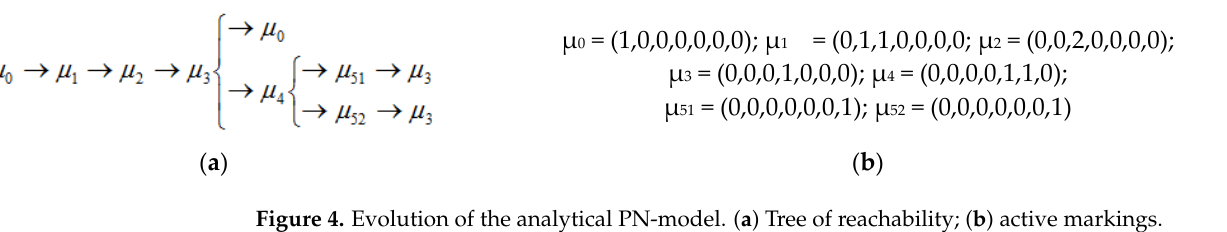
Figure 4. Evolution of the analytical PN-model. ( a ) Tree of reachability; ( b ) active markings.